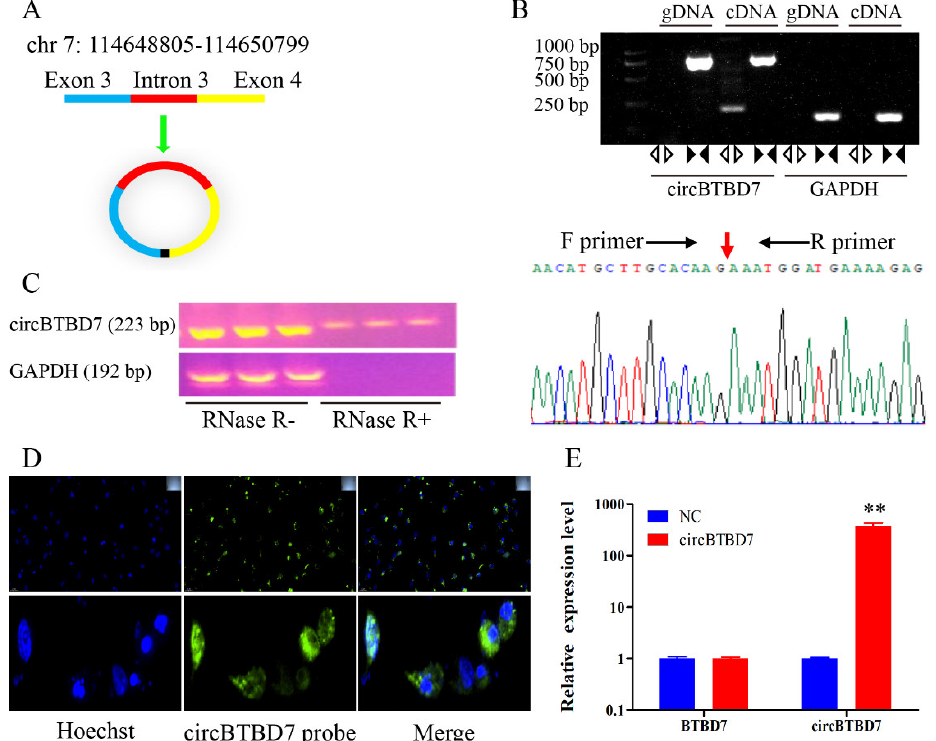
Figure 1. Characteristics of circBTBD7 in immature porcine Sertoli cells. ( A ) The sequence structure of circBTBD7 (Sus scrofa 11.1) predicted using a bioinformatics algorithm. ( B ) RT-PCR was conducted to validate the circBTBD7 sequence in cDNA and gDNA using divergent or convergent primers. The back-splice junction of circBTBD7 was further confirmed by Sanger sequencing. ( C ) The stability of circBTBD7 was validated by the RNase R digestion treatment. The total RNA from immature porcine Sertoli cells was treated with RNase R for 15 min before the RT-PCR assay. ( D ) The subcellular location of circBTBD7 was detected using the FISH assay. 100× (upper images) and 400× (bottom images). ( E ) The overexpression efficiency of circBTBD7 was measured using the qRT-PCR assay ( n = 3). The pig-TBP gene was used as the internal control. Data are presented as the mean ± S.D. ** p < 0.01.